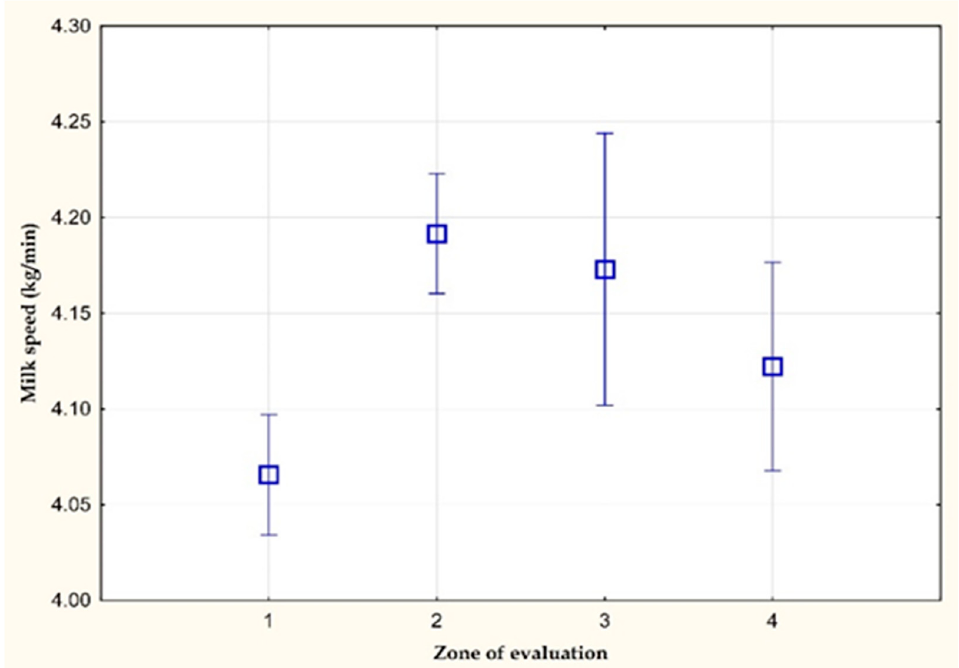
Figure 6. The maximum milk speed (kg/min) on farm D.